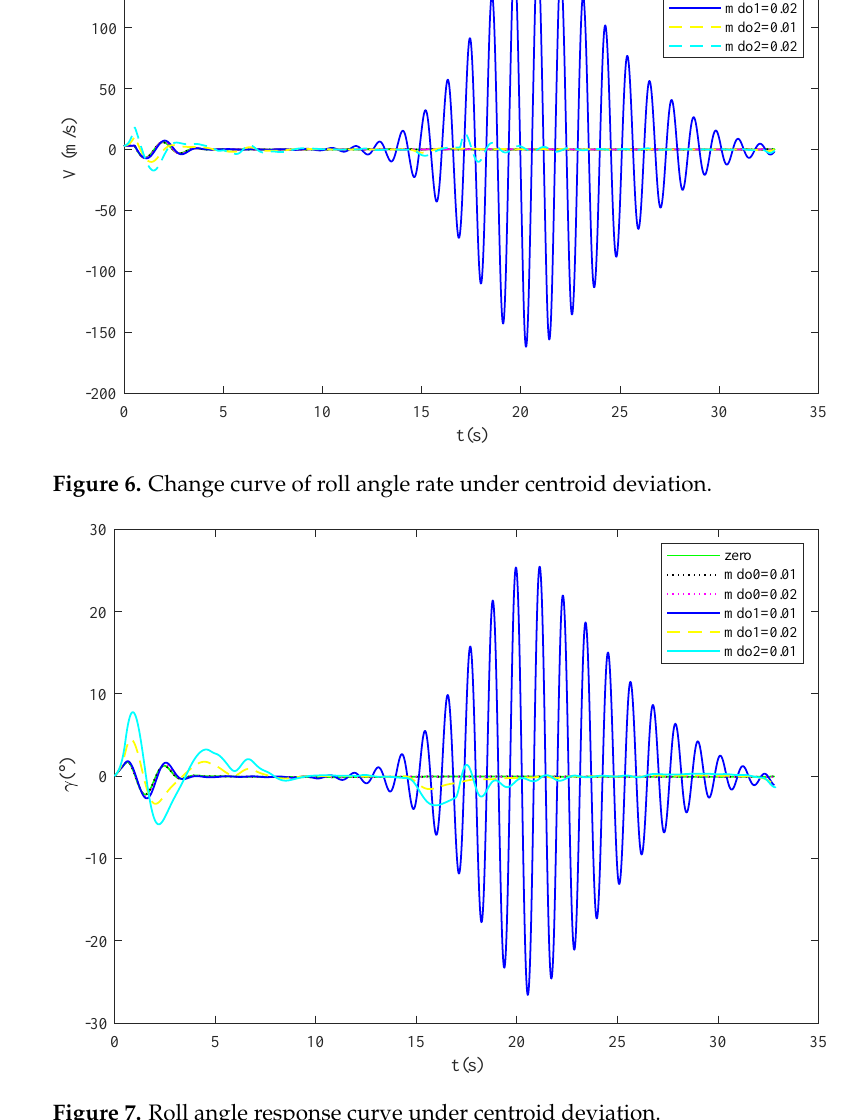
Figure 7. Roll angle response curve under centroid